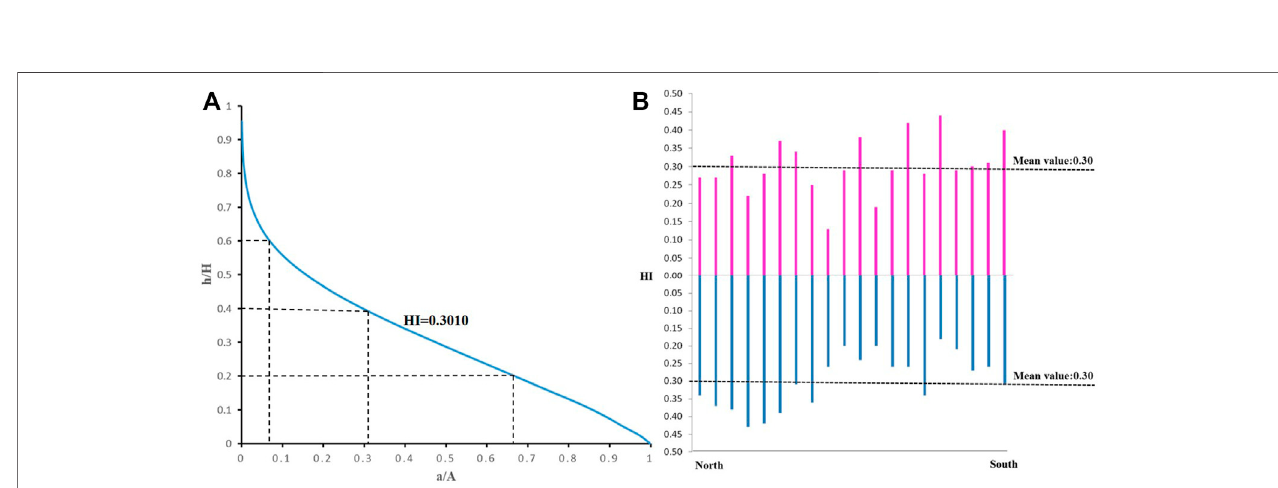
FIGURE4| HypsometriccurvesoftheaveragetopographicdevelopmentcurveintheGreaterKhinganMountains (A) ;hypsometricintegral(HI)andmeanvaluesin the Greater Khingan Mountains (B) .